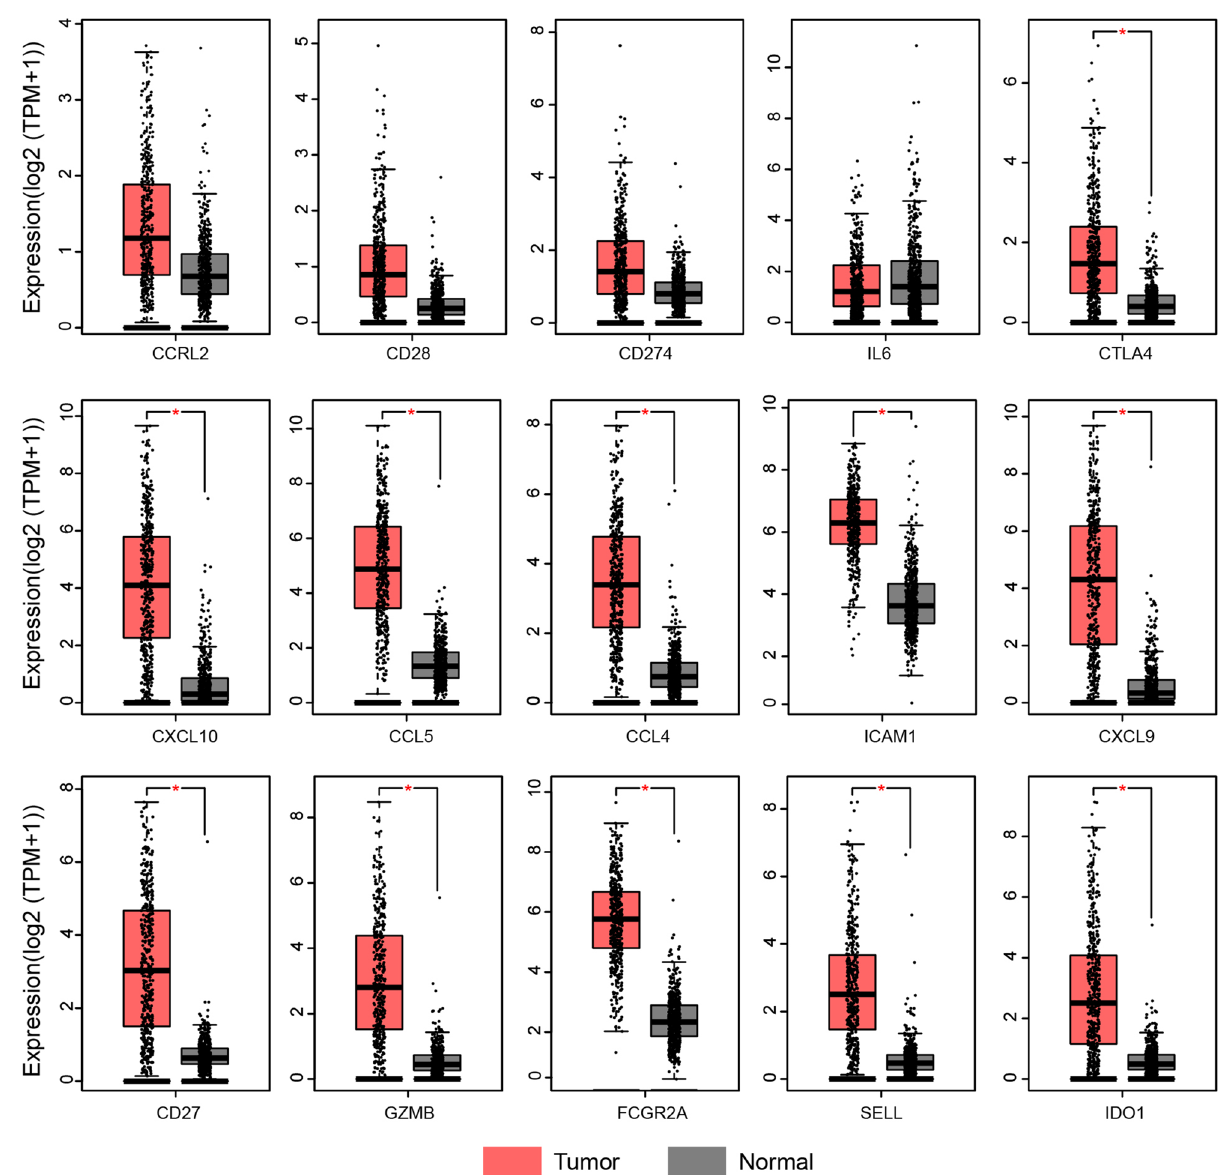
Figure 4. Expression level of hub genes in SKCM compared with normal tissues. Melanoma was compared with normal tissues in the GEPIA database, red represents tumor tissue and gray represents normal tissue. SKCM skin cutaneous